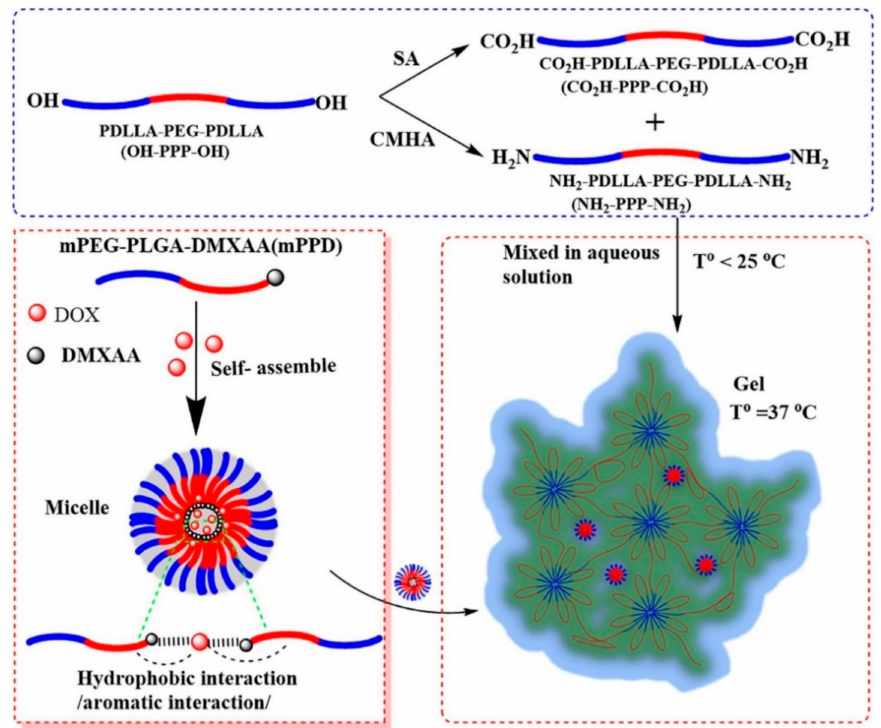
Figure 10. Schematic illustration of the thermoresponsive hydrogel-micelles for DOX delivery and cancer treatment. Reprinted with permission from [177]. Copyright © 2021,